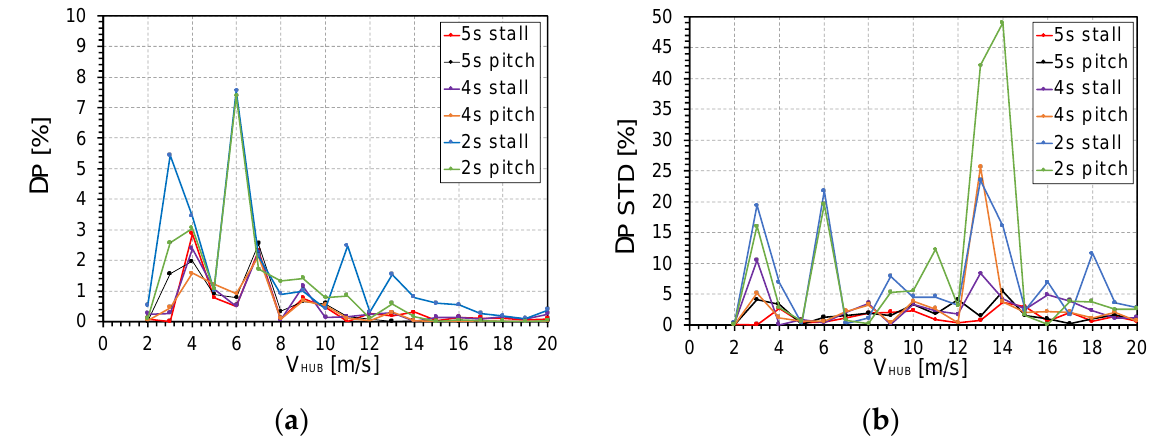
Figure 7. Relative error of power ( a ) and power standard deviation ( b ) per wind speed bin with respect to six speeds per wind speed value, using 5 (5 s), 4 (4 s), and 2 (2 s) turbulent speeds per wind speed. Table 4. Statistical convergence of annual energy production